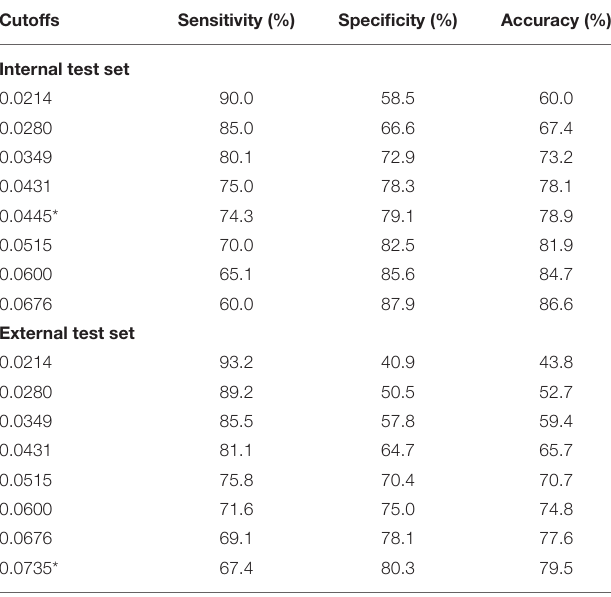
TABLE 3 | Performance of the XGBoost model for mortality in the following 48h at different cutoffs. Cutoffs